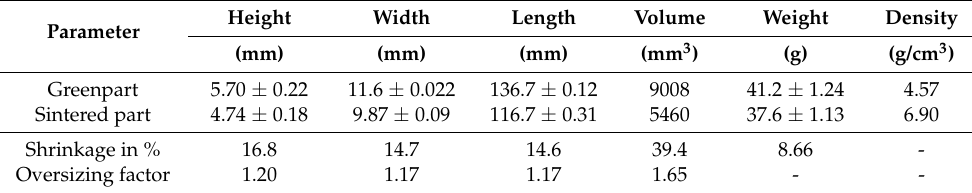
Table 4. Geometrical properties, mass and density of cylinders with 100% infill ( n = 6).